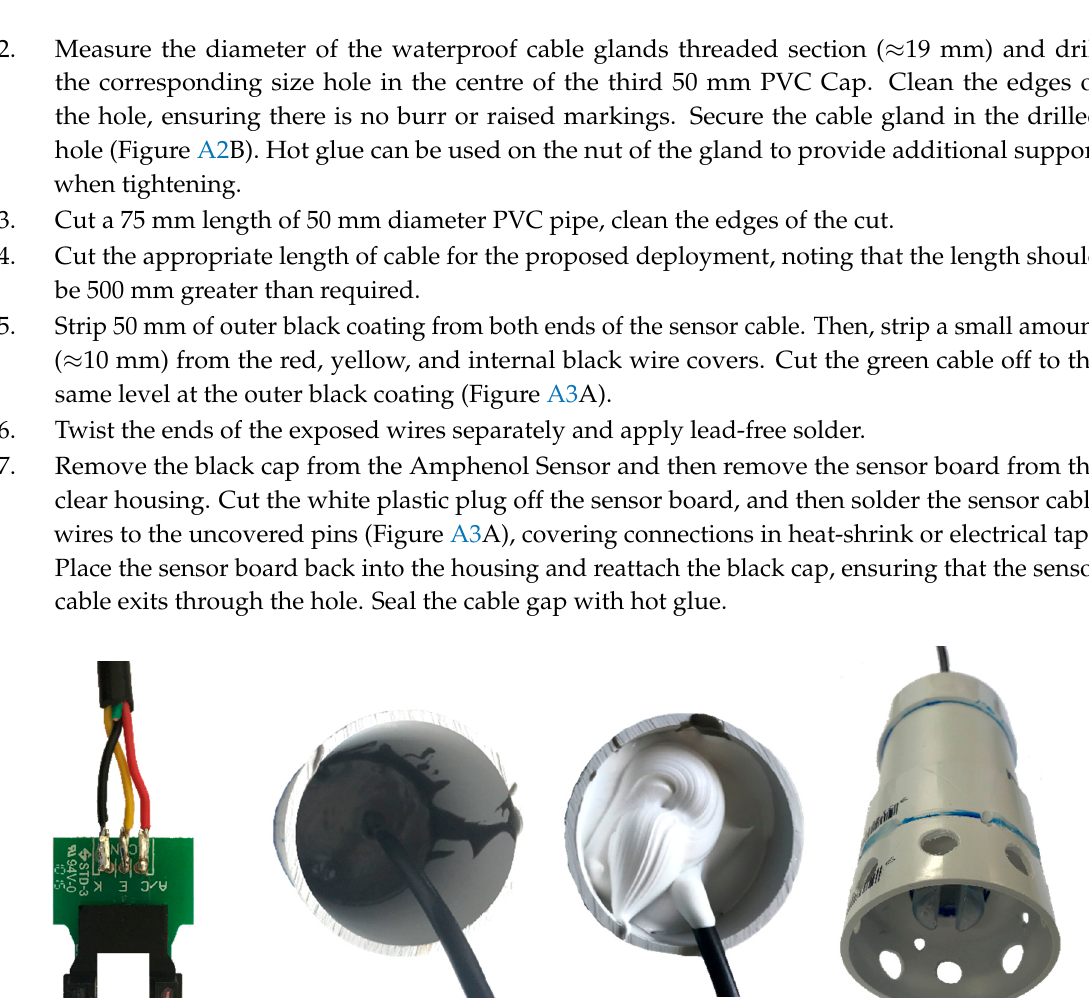
Figure A3. ( A ) Illustrating the cable soldered on the sensor board, ensuring the solder does not bridge between the sensors. The wires connected as; Red to A/C, Black to K, and Yellow to E. ( B ) Epoxy-filled sensor housing. The harder epoxy is first to provide a dense base, and hold the cable firmly in place to prevent movement of the soldered joint. ( C ) Silicon filling is used in the top to provide a more flexible housing fill so the cable can be positioned for the top cap. ( D ) Completed sensor assembly.